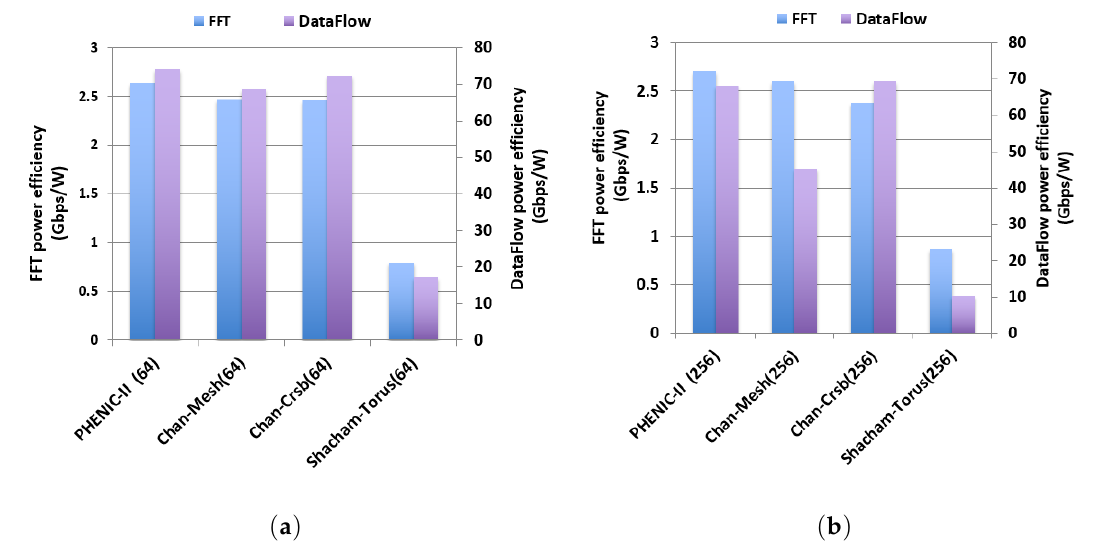
Figure 18. Power efficiency comparison results: ( a ) 64 cores; ( b ) 256